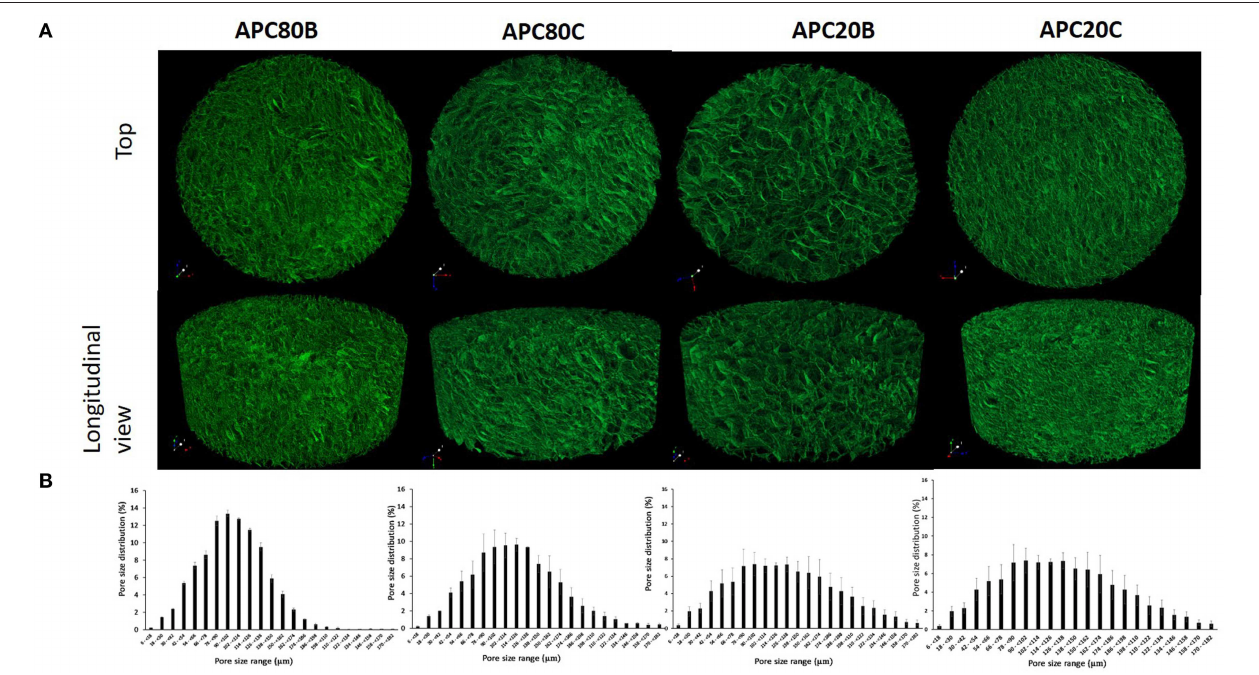
FIGURE 4 | Representative images obtained from the 3D reconstructions of the ApSF/chitin-based sponges by micro-CT (A) top and longitudinal views and (B) the mean pore size distributions.